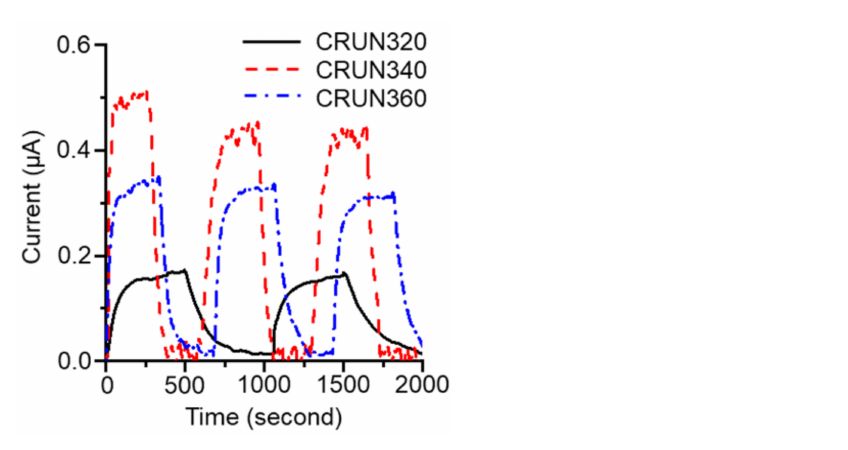
Figure 6. The current change in CRUNs occurred by switching the purge gas between carbon dioxide and nitrogen. See Supplementary Information for the experiment